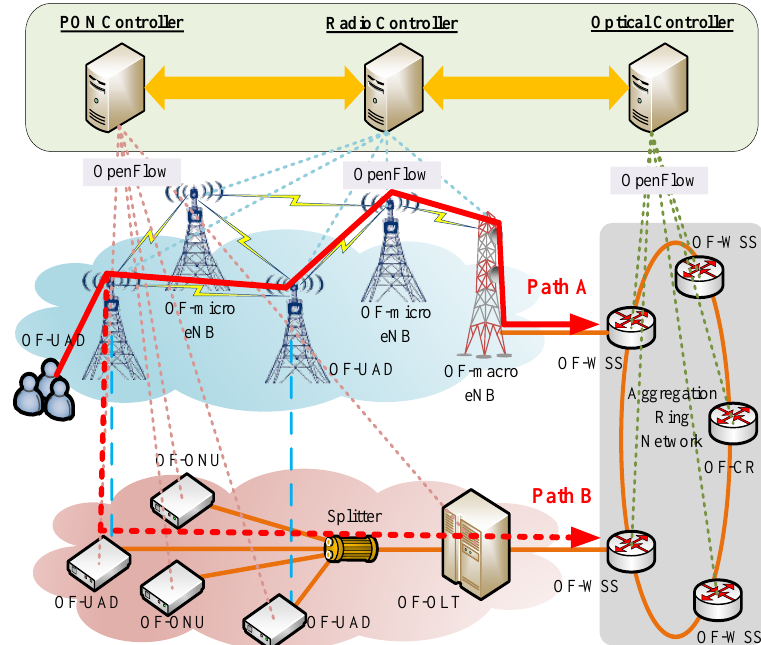
Figure 2. Unified control architecture in optical access network.